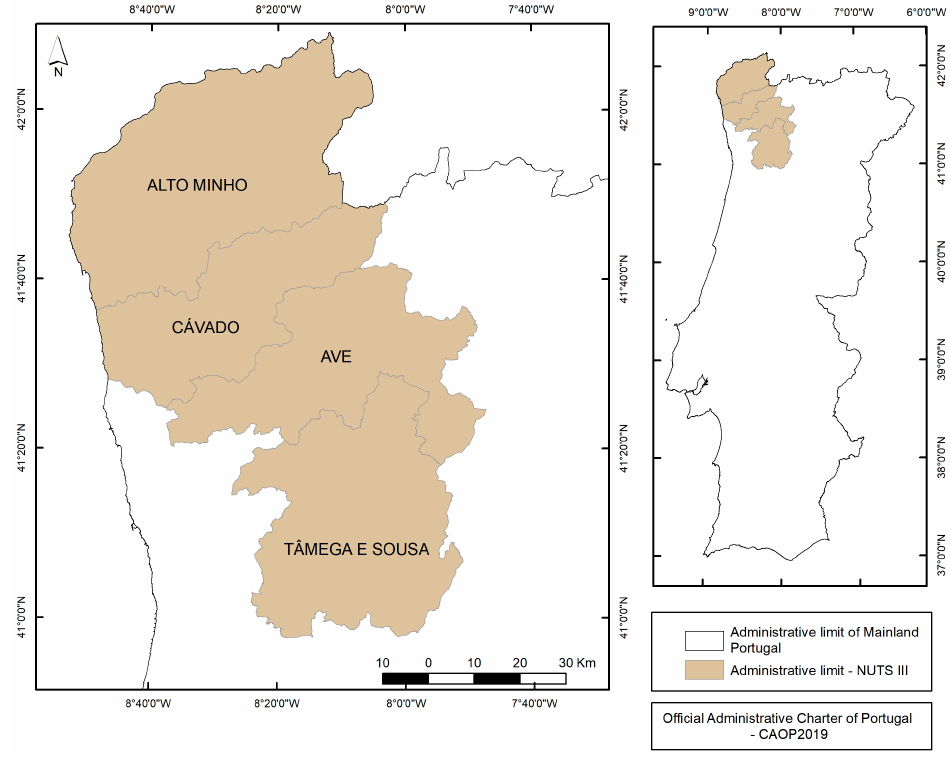
Figure 1. Location of the study area in northwestern Portugal.